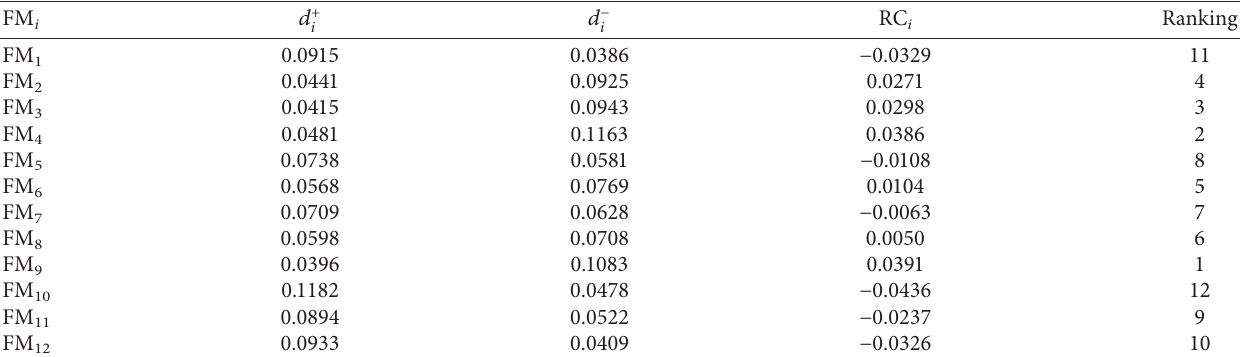
Table 4: Results of the modified TOPSIS